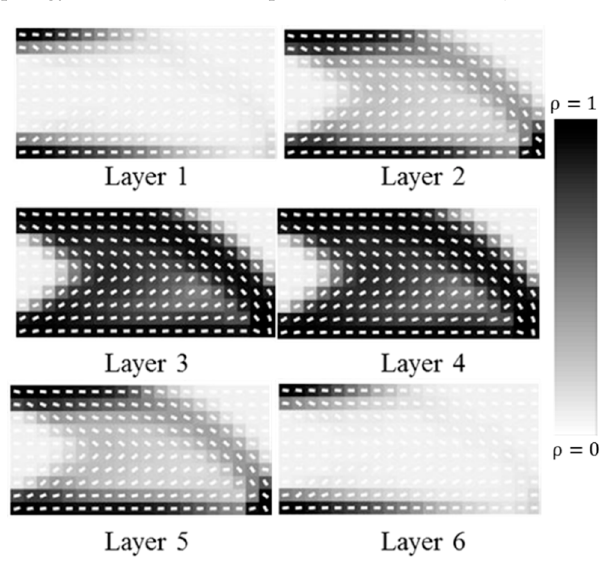
Figure 12. Optimized material distribution and material angle, layer-by-layer plots for Case 1. Layer 1 corresponds to the back layer, and layer 6 corresponds to the front layer.